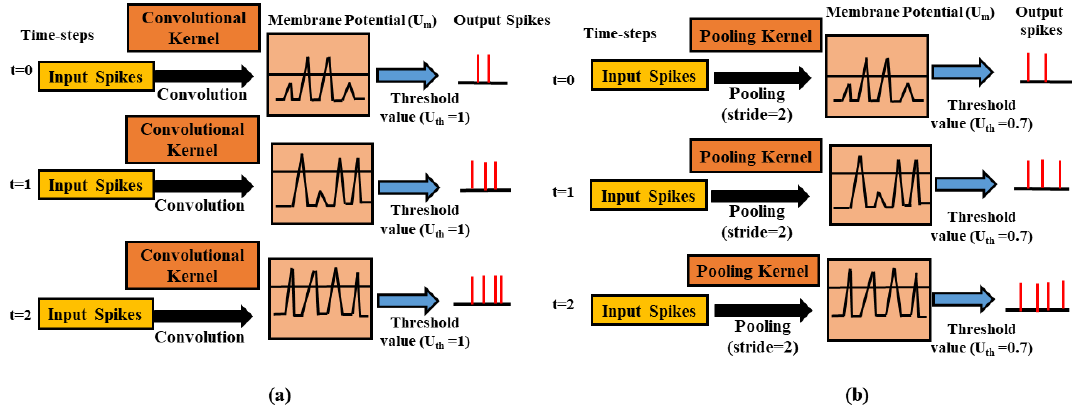
Figure 2. Demonstration of convolutional ( a ) and average-pooling method, ( b ) above three different time-steps. At a given time interval, the pre-neurons or spikes are combined with convolutional or pooling kernels to measure the input current, which is then combined into the neuron’s membrane potential, U m ( t ) at each time-step. If the membrane potential of that neuron U m ( t ) is greater than a specified threshold value U th , the spikes are produced, and U m ( t ) goes to its initial value, i.e., 0. Alternatively, over the next time step, U m ( t ) is assumed to be residual while leakage throughout the current